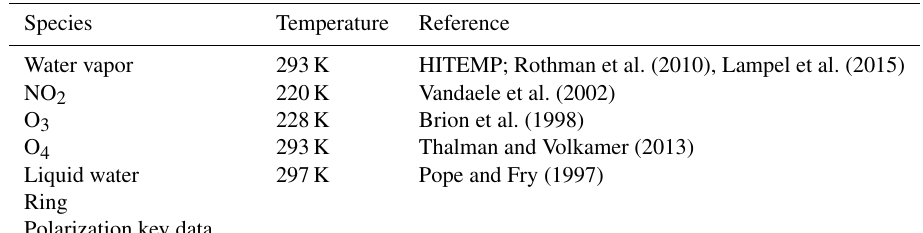
Table 2. The spectral fit settings for the retrieval of water vapor slant column.